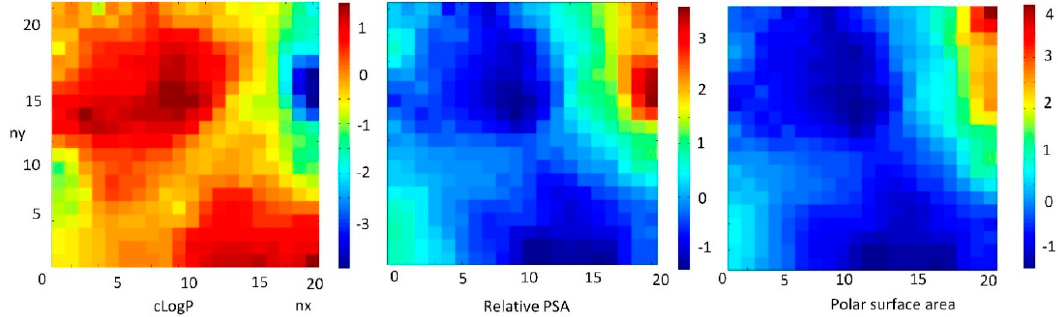
Figure 8. Weight maps of inversely correlated cLogP with polar surface area (PSA) and relative